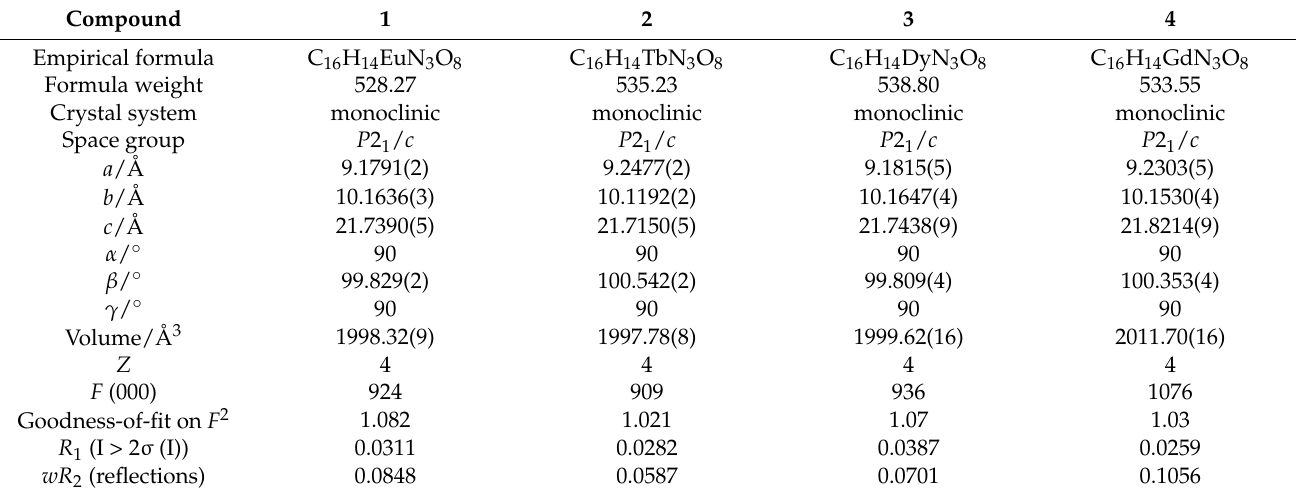
Table 1. Crystal data and refinement results for compounds 1 – 4 .